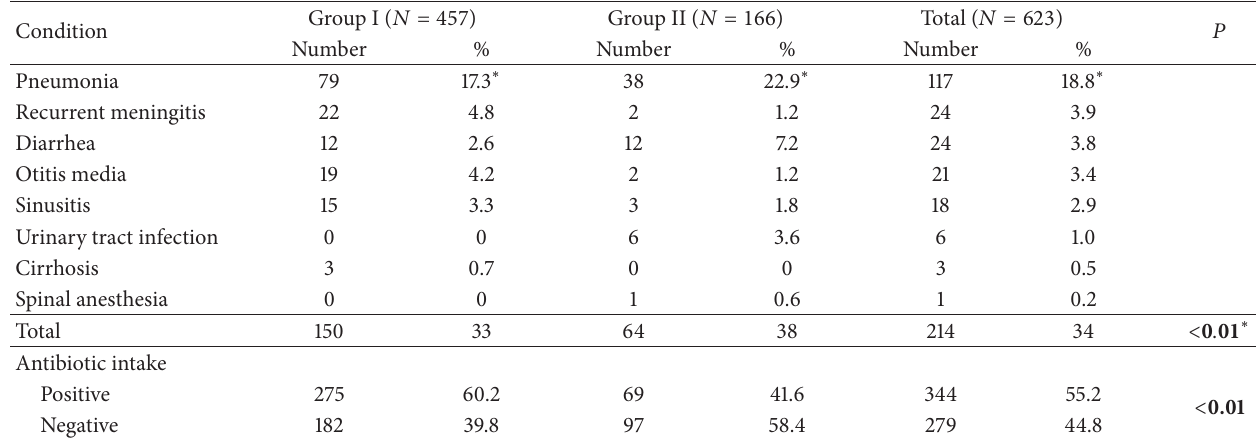
Table 3: Clinical manifestations of bacterial and aseptic meningitis in the studied population.